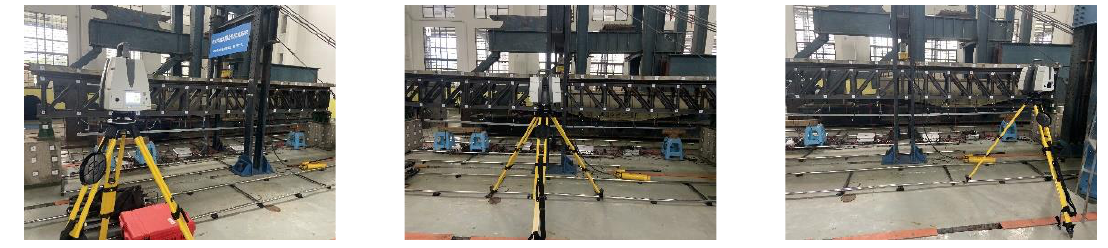
Figure 9. Three-dimensional laser scanning validation test.